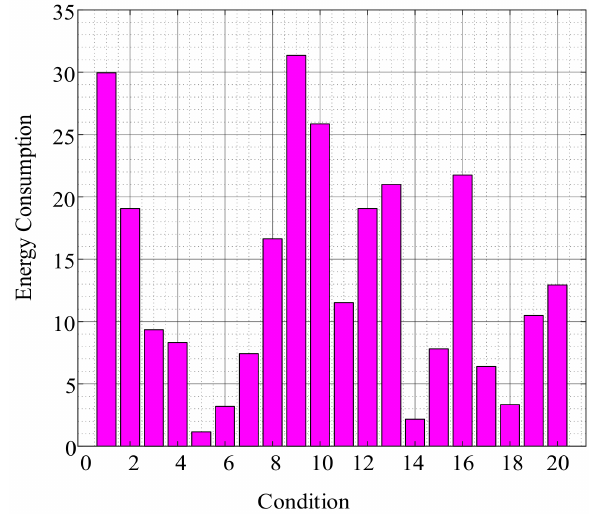
Figure 15. Energy for fourth line condition.